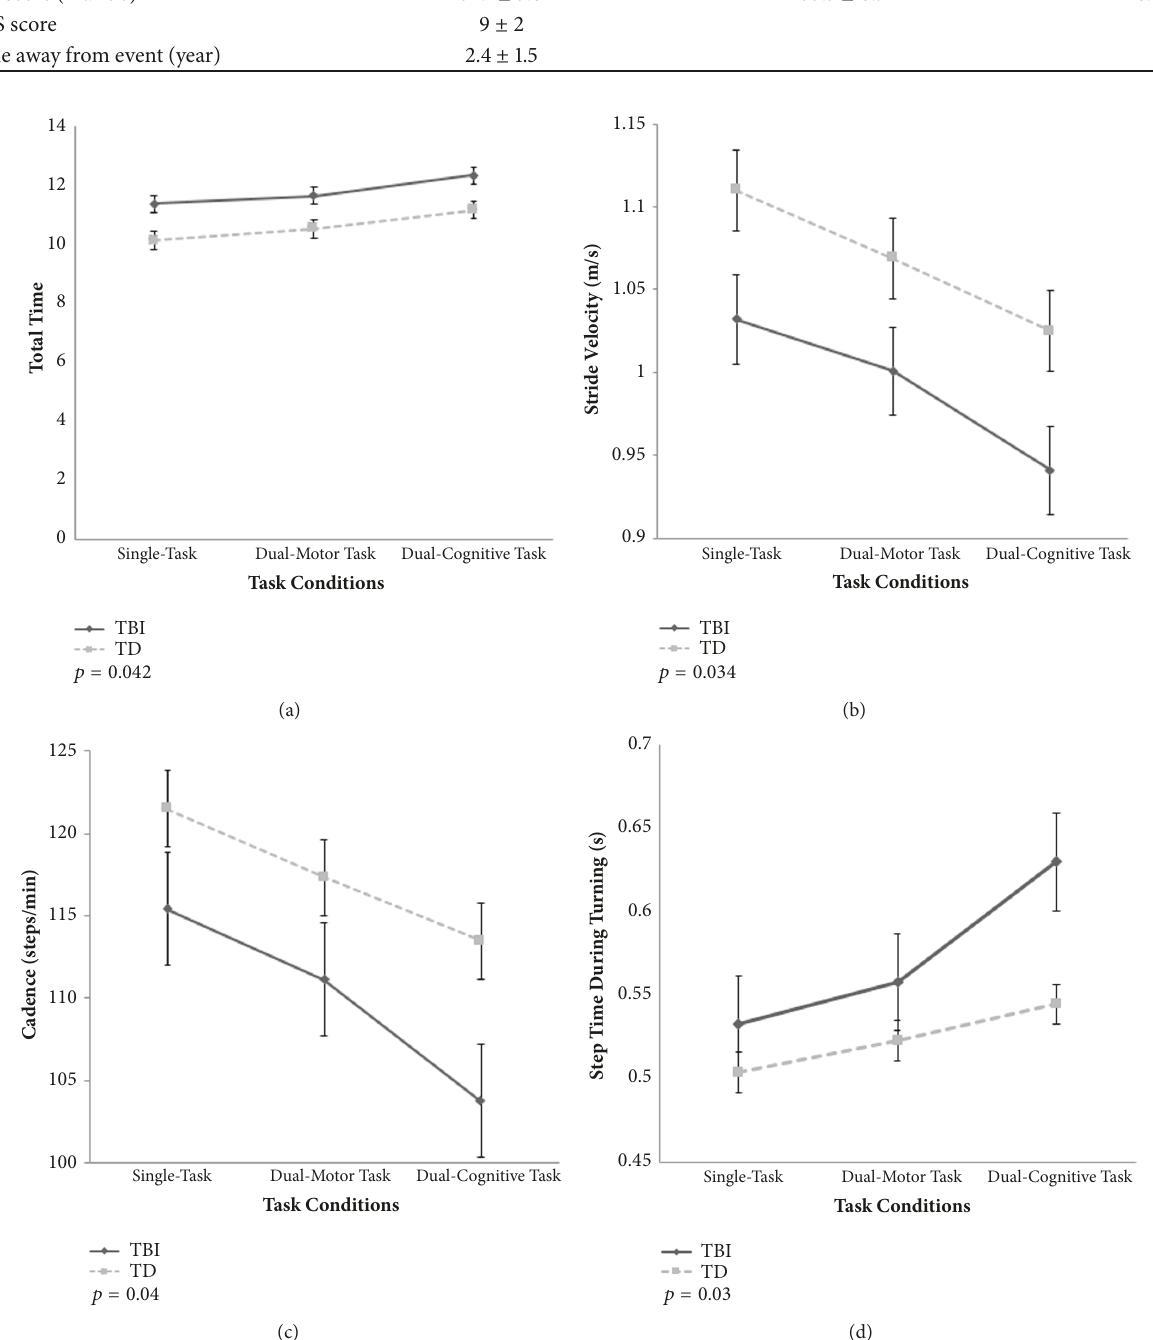
Figure 2: Comparison of gait parameters between dual-task conditions: (a) total time taken to complete the modified timed up and go test; (b) stride velocity of the straight walking phase; (c) cadence of the straight walking phase; (d) step time during turning. TBI, traumatic brain injury; TD, typically